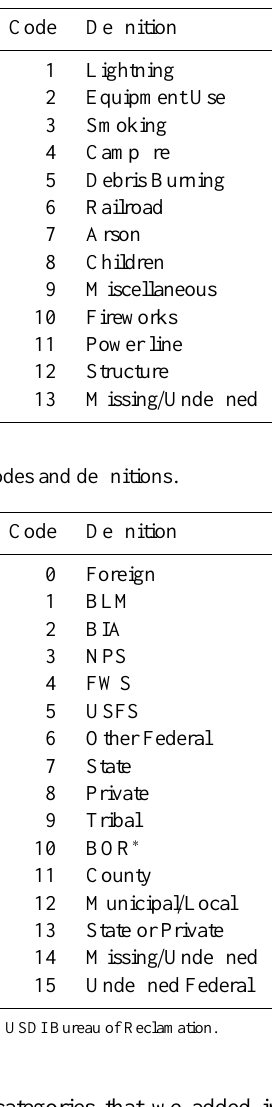
Table 5. Protection type codes and definitions (adapted from